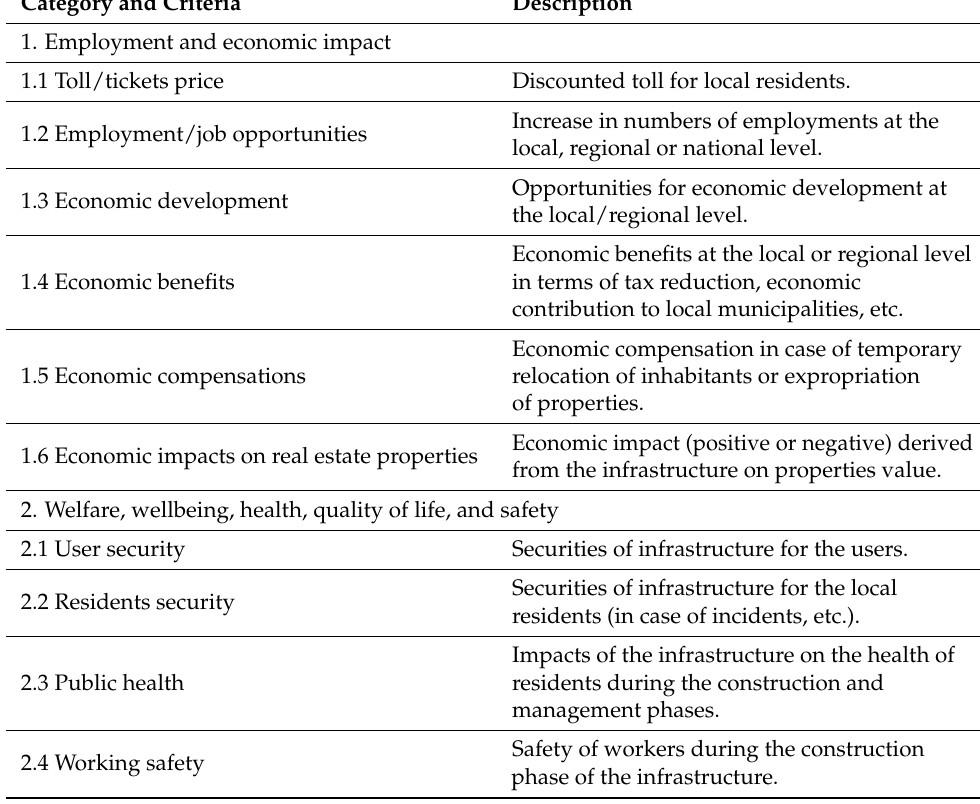
Table 3. Table of selected criteria. Category and